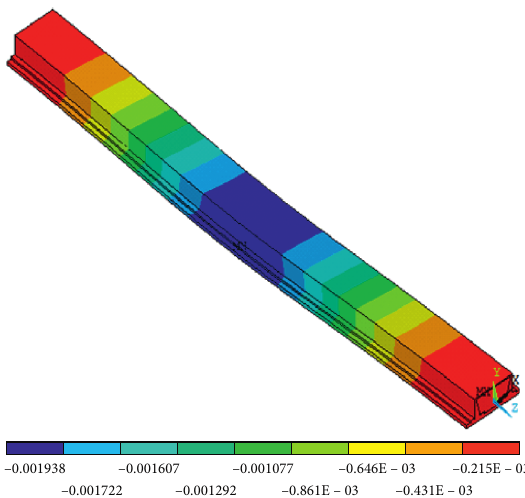
Figure 9: Construction effect after grouting.